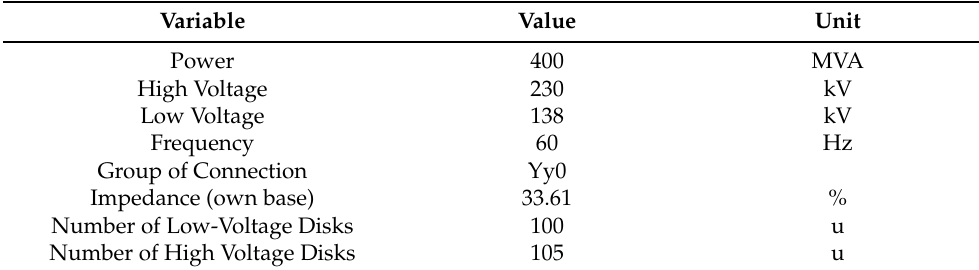
Table 1. Power transformer under analysis.